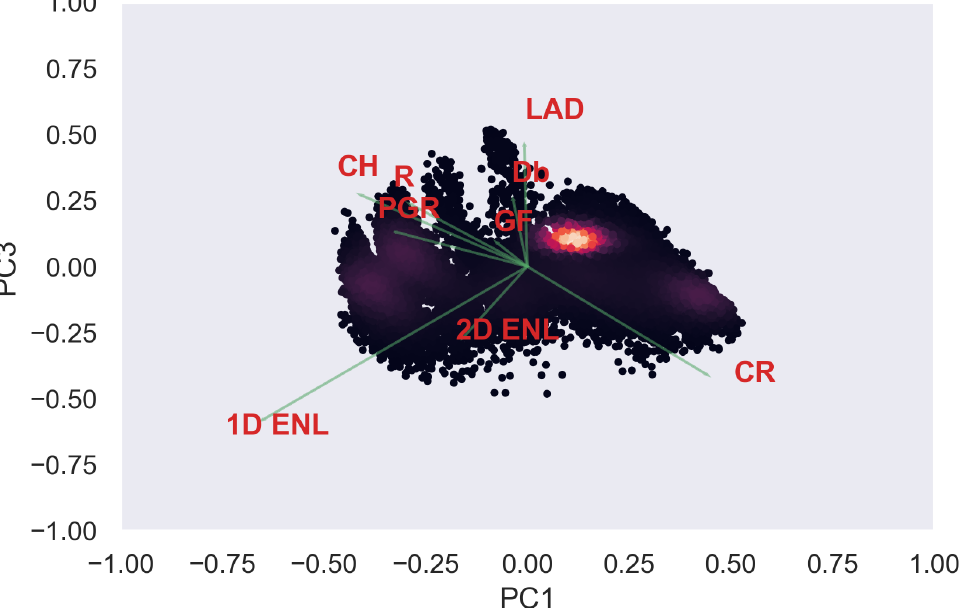
Figure A16. ULS PCA band 1 and 3 loadings at 0.5 m grid size.